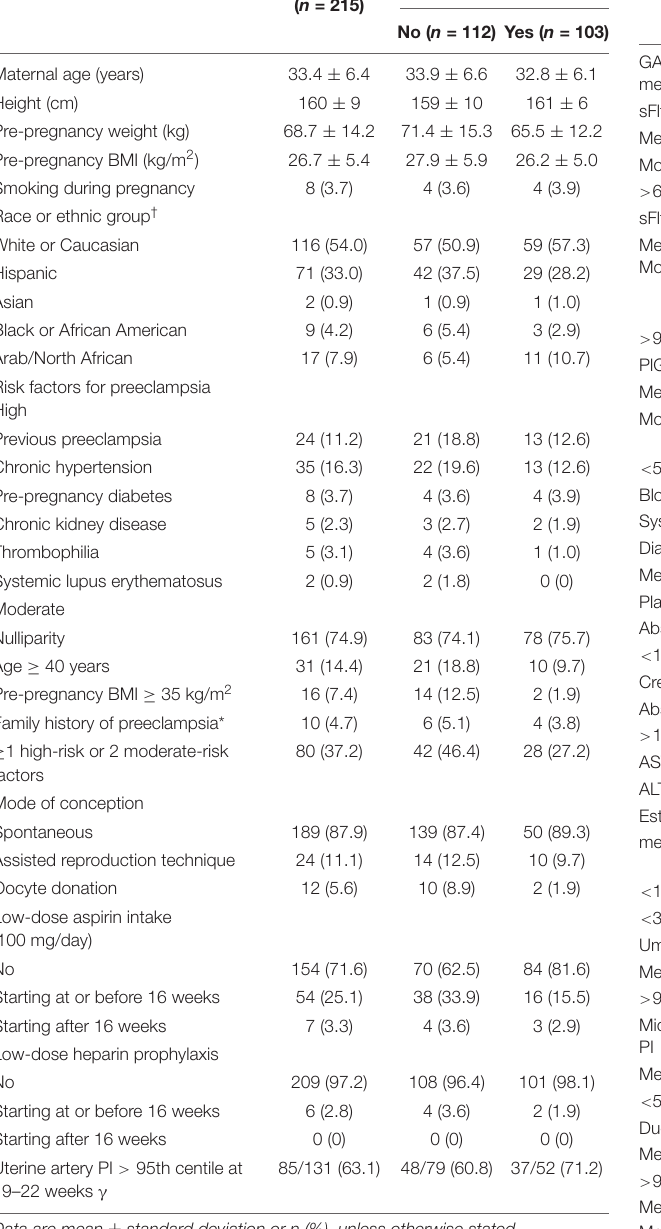
TABLE 1 | Baseline characteristics of the study population stratified by the presence of preeclampsia complications within 7 days of diagnosis. Characteristics